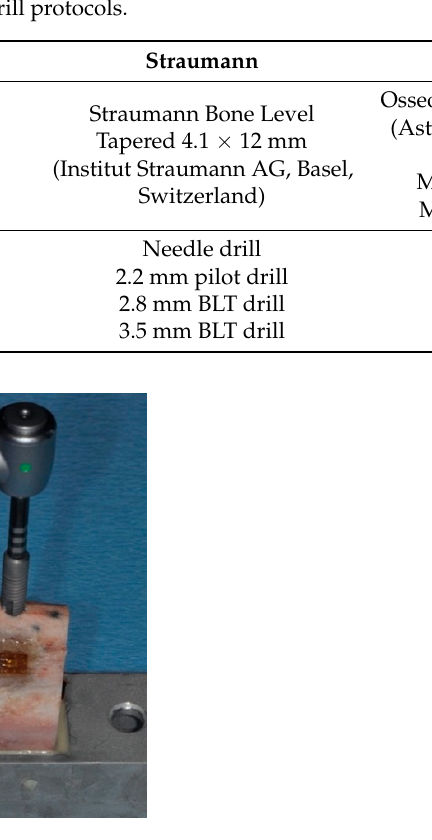
Figure 1. Insertion of an OsseoSpeed implant in bovine rib bone, which has been positioned in a metal holder and equipped with a strain gauge on the buccal surface. The sensing element of the strain gauge is positioned in the horizontal direction. Table 1. Implant types and drill protocols